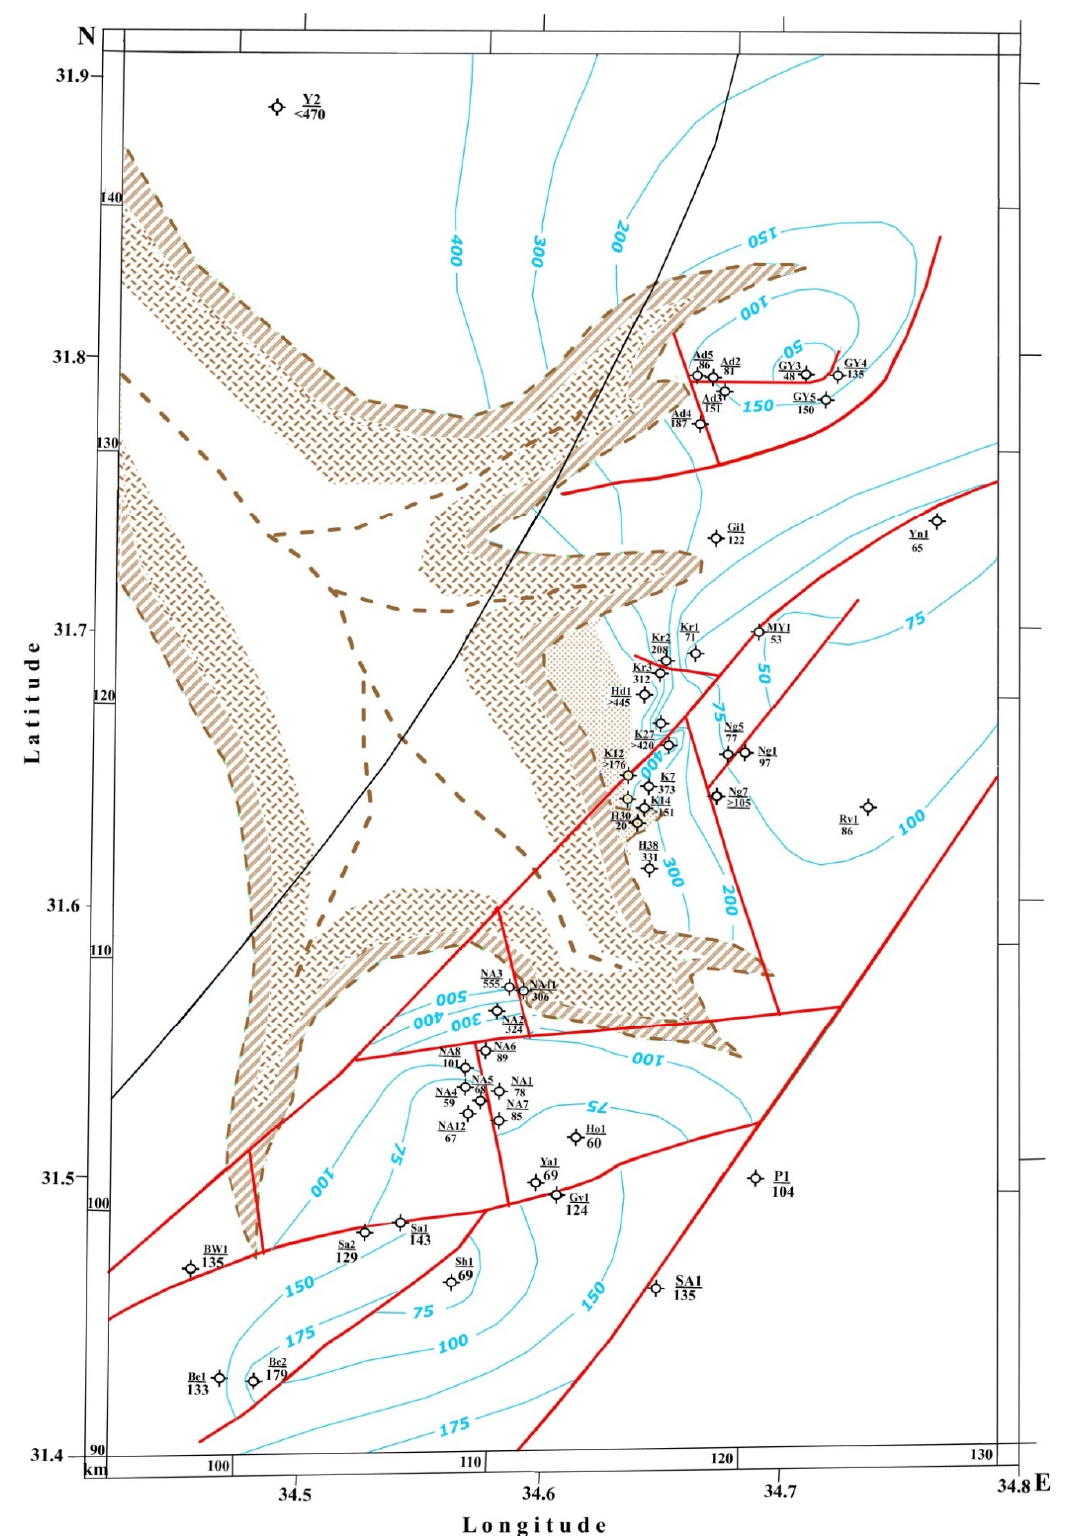
Figure 9. A map of the thicknesses of the Middle Oxfordian (Beer-Sheva Formation) of the Heletz– Ashdod oil field. The brown color shows the erosional canyon, and blue lines are the isopachs. Borehole abbreviations: see captions for Figure